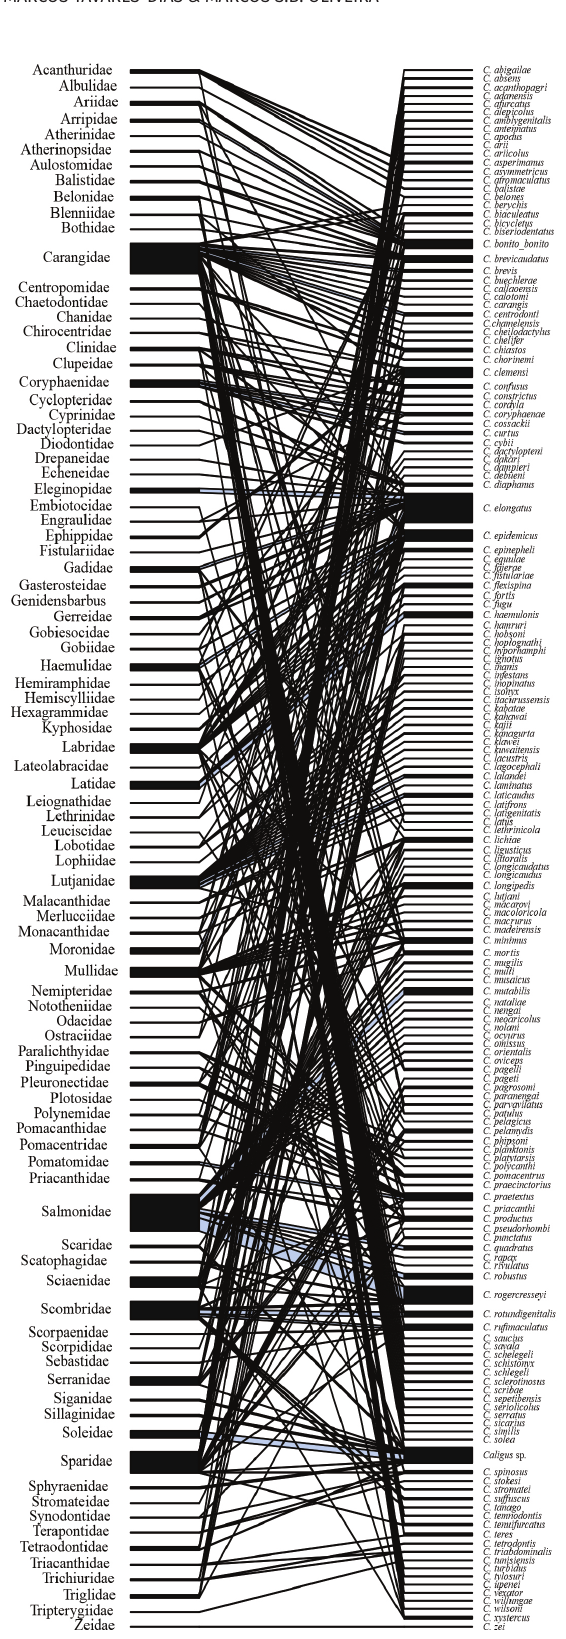
Figure 1. Network of interactions between species of Caligus and families of host